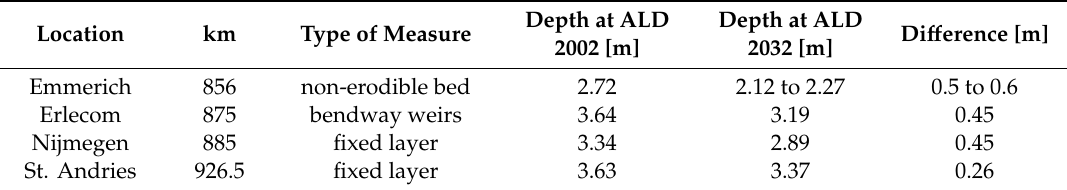
Table 3. Overview of depth above structures in navigation channel at ALD 2002 and ALD 2032 (copyright